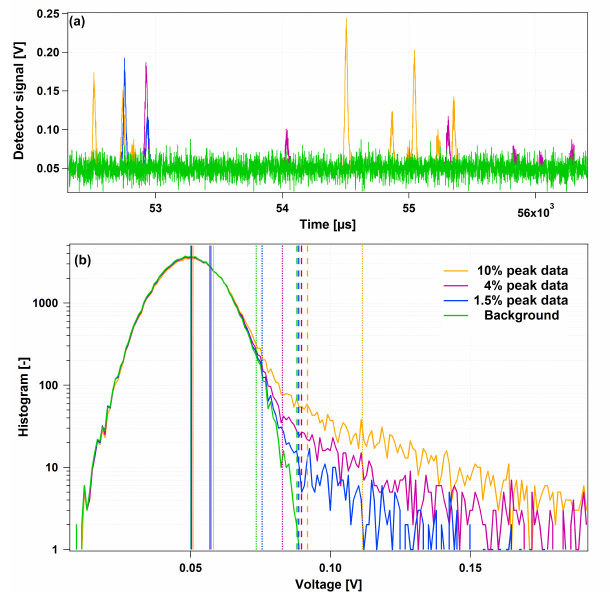
Figure 4. Simulated detector signal data without (green lines) and with a different number of particle peaks (blue, purple and or- ange lines). Panel (a) shows a short segment of the simulated data, whereas panel (b) shows the histograms of the data points on a log- arithmic scale as a function of the detector voltage signal. See the text for details on the meaning of the vertical lines.